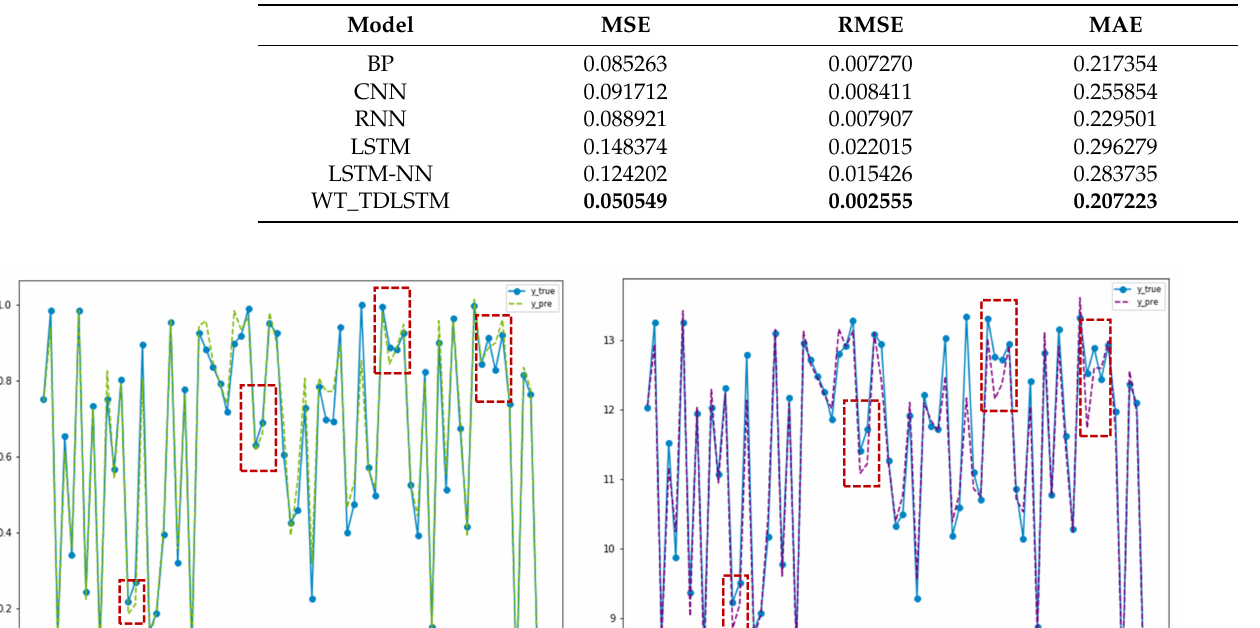
Table 5. Five randomized experimental average results of all the models on the industrial monthly electricity price dataset.